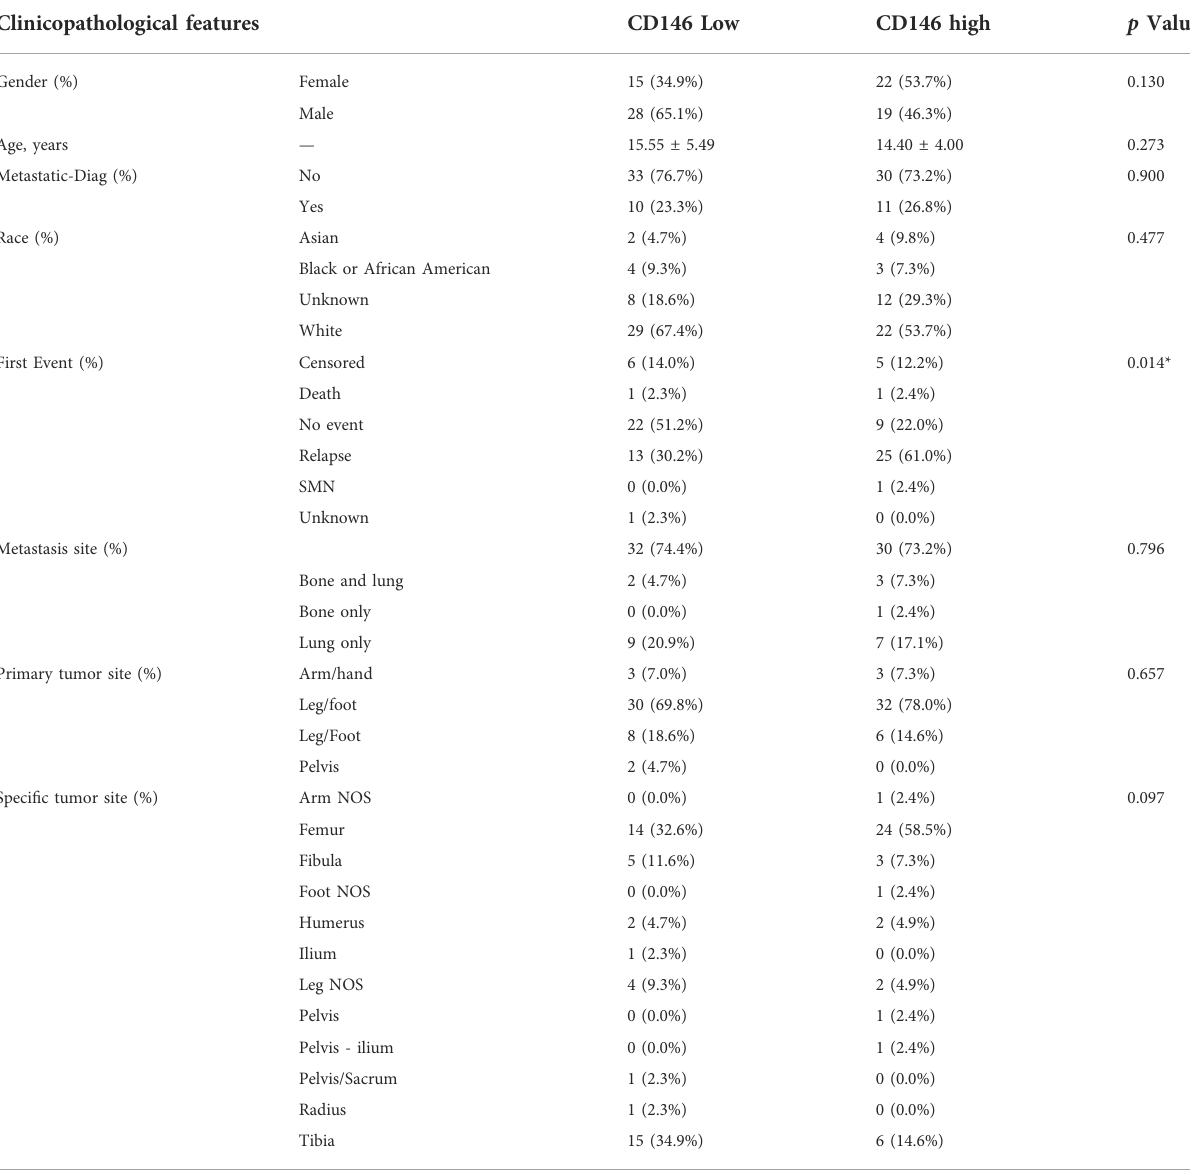
TABLE 1 Clinical features of the CD146 low and high groups in the TARGET-OS cohort. Clinicopathological